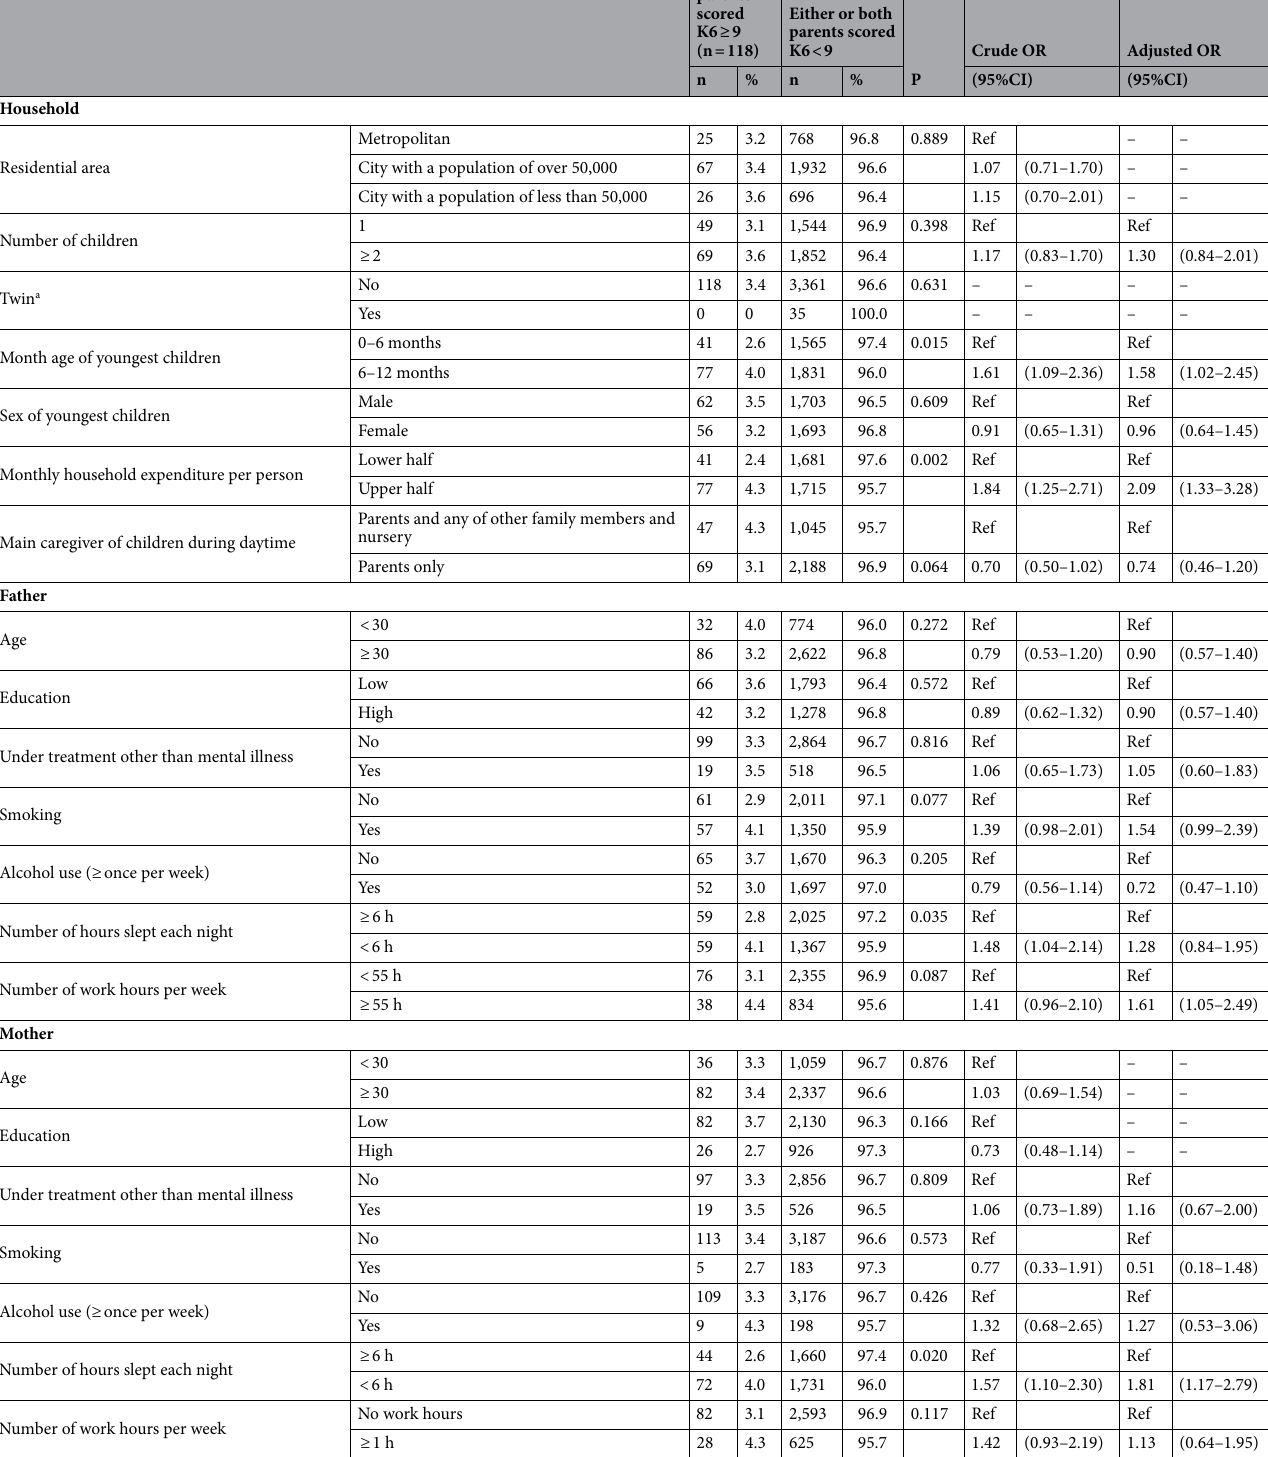
Table 3. Crude and adjusted odds ratio between parental psychological distress (both parents scored K6 ≥ 9; MPD or SPD) and potential risk factors such as socio-economic status, health behavior, and working situation among Japanese parents. (n = 3,514). 2,773 couples were included in the multivariate